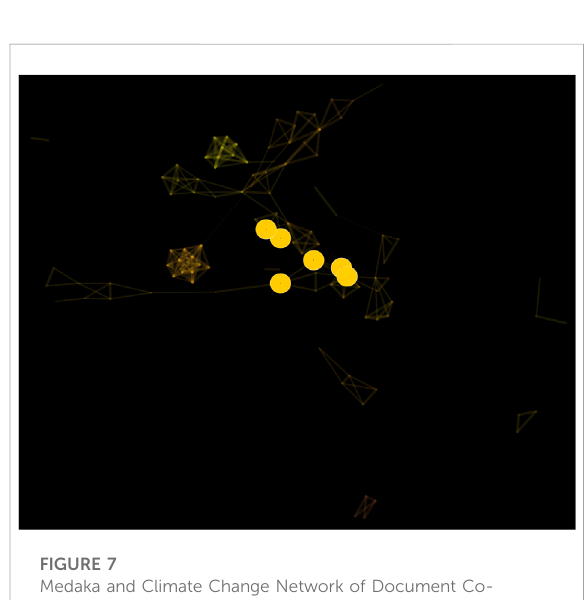
FIGURE 7 Medaka and Climate Change Network of Document Co- citation Analysis, where articles with acentrality score greater than 0.1 are